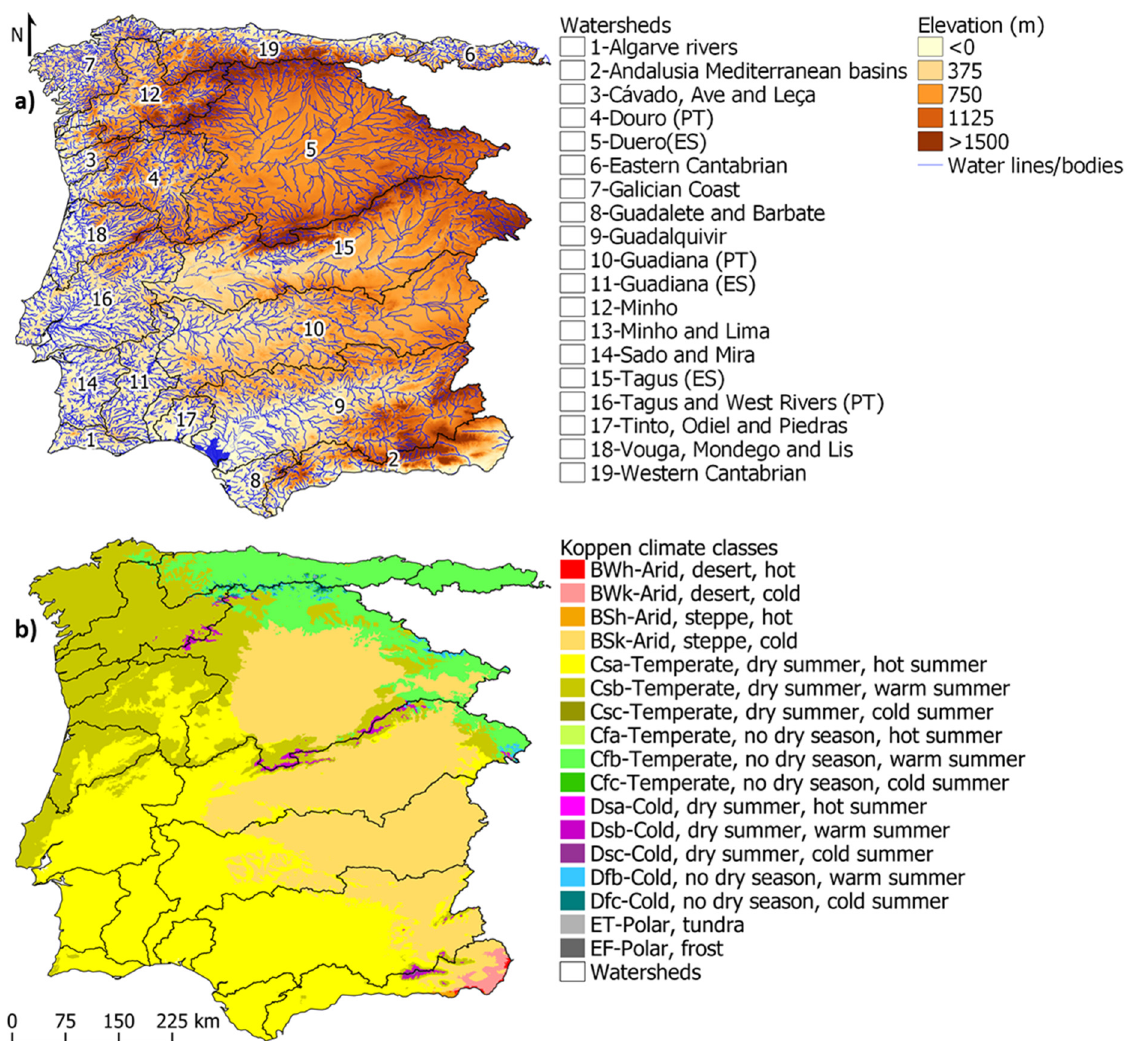
Figure 1. Study area: ( a ) Watershed’s identification and digital terrain model; ( b ) Koppen climate characterization according to Beck et al. [39].